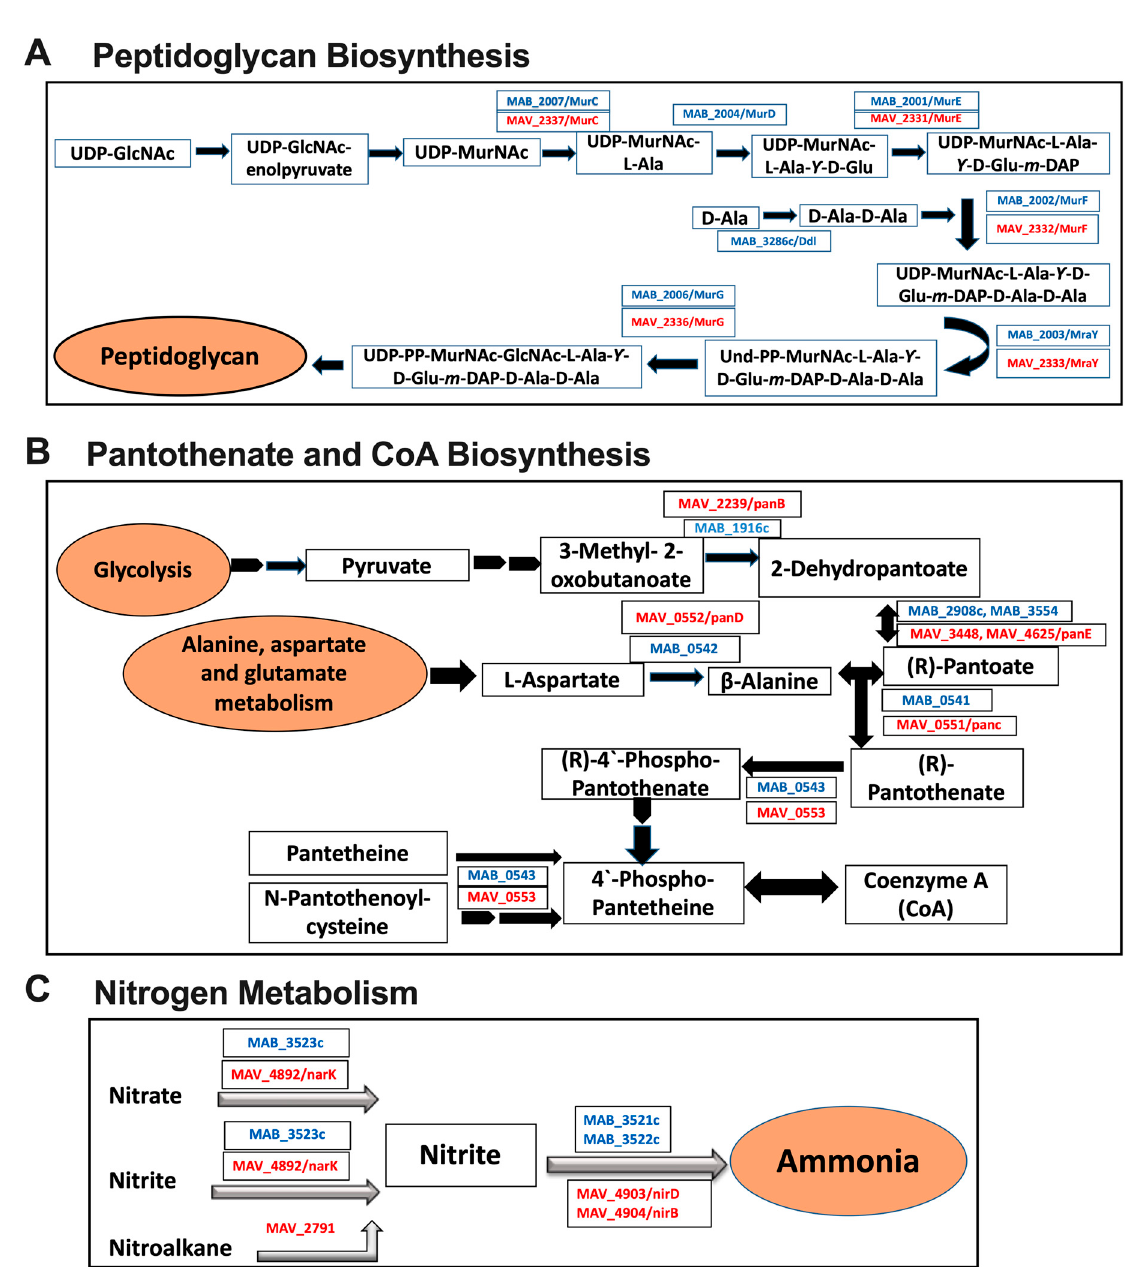
Figure 8. MAH and MAB common enzymes associated with metabolic pathways. ( A )